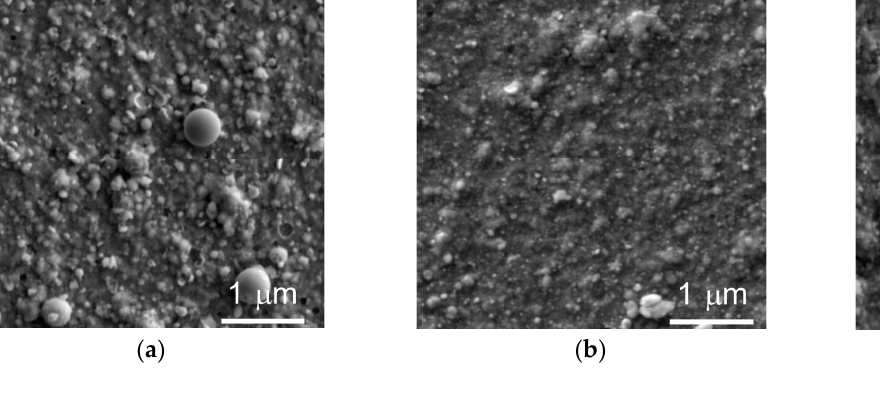
Figure 1. SEM images of the surface of coatings obtained by pulsed laser ablation of a WSe 2 target ( a ) under vacuum condition and ( b , c ) in reactive H 2 S gas at pressures of 3.6 and 9 Pa, respectively.